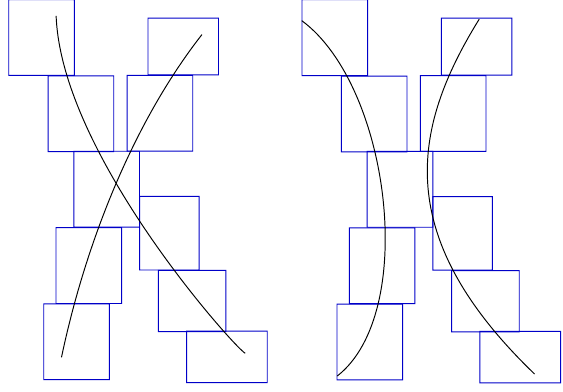
Figure 3. Two identical box coverings with two possible couples of covered curves.